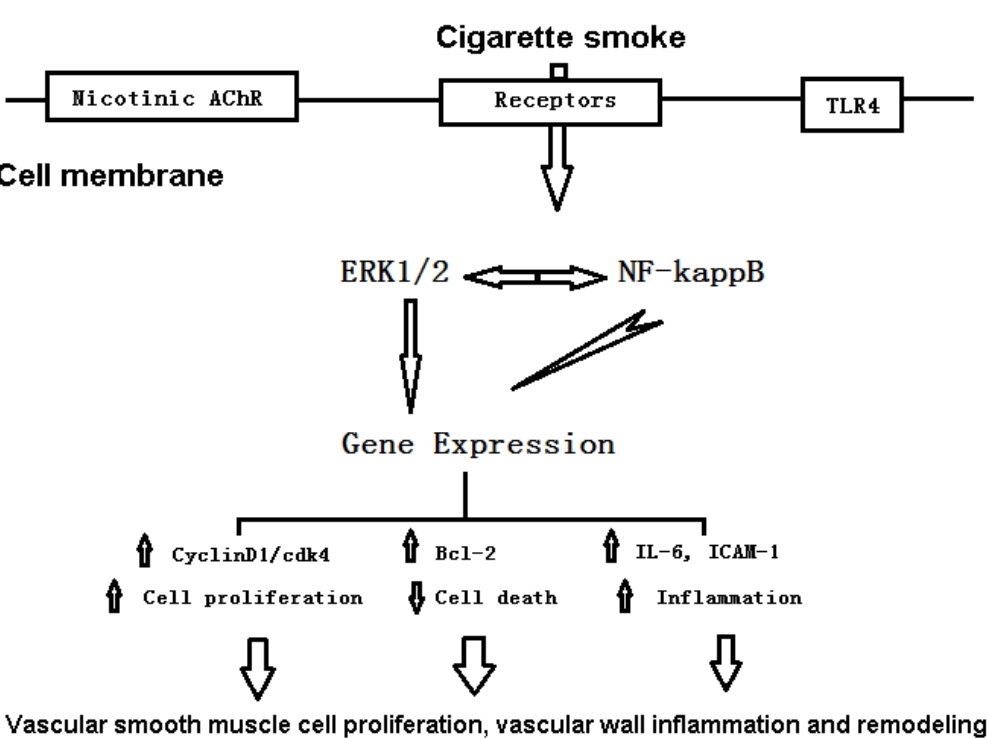
FIGURE 2. Schematic diagram of the pathways activated by cigarette smoke in human VSMCs. The diagram shows the signal pathways that may involve DSP-induced cell proliferation, anti–cell death, and inflammatory response in